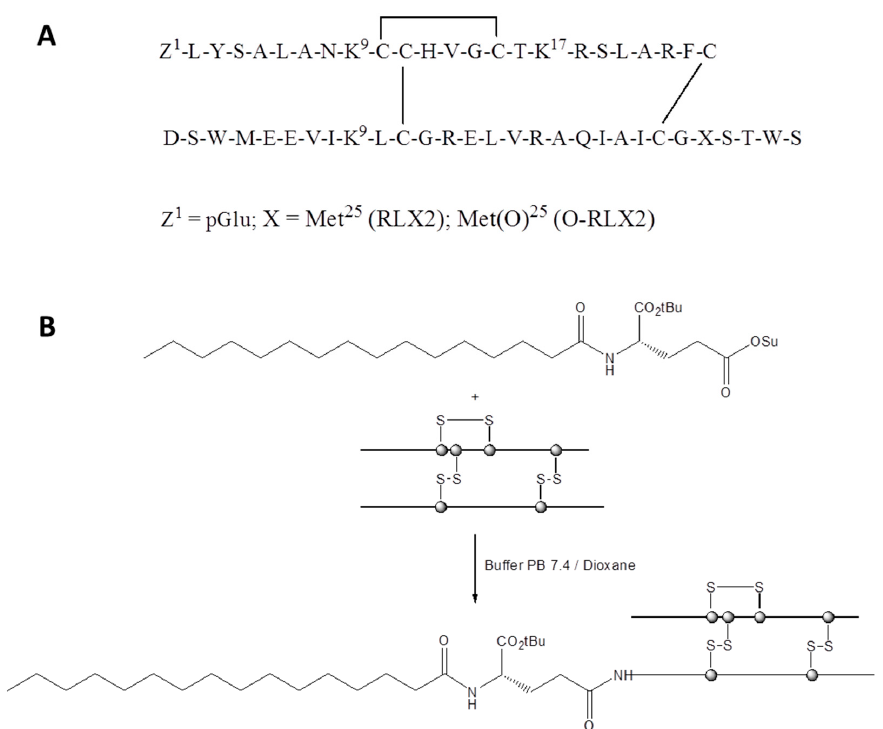
Figure 1. ( A ) Structure of human relaxin 2 (RLX2) and Met (O) 25 -human relaxin 2 (O-RLX2). ( B ) Synthesis of P-RLX2 by the reaction of Palmitoyl- L -Glu(OSu)-OtBu and human relaxin 2 (RLX2).